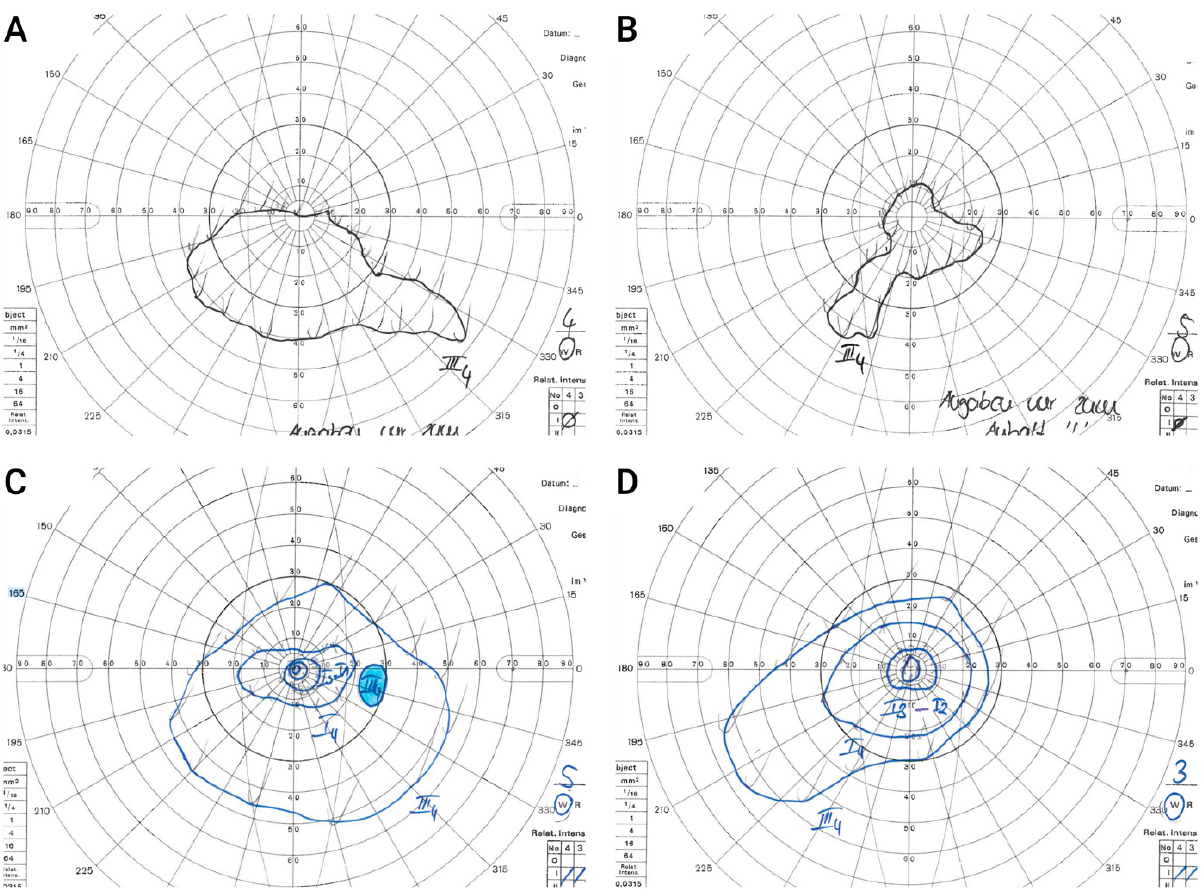
Figure 6. Goldmann Visual fields in a 6-year-old child before and after gene therapy. Upper Panel shows visual fields of a 6-year-old child (P4). Before surgery, he was able to give only vague information about the visual field outer limits in both the right ( A ) and left ( B ) eye due to severe visual impairment. After surgery, reliable field testing using targets I 1 –I 4 and III 4 as well as defining the blind spot was possible in the right eye 6 months after treatment ( C ). In the left eye, visual field testing using targets I 2 , I 3 and III 4 could be performed 8 months after therapy ( D ). The illustrated isopters correspond to the aforementioned targets and represent contour lines of the hill of vision. Both eyes showed marked enlargement of the visual field after gene